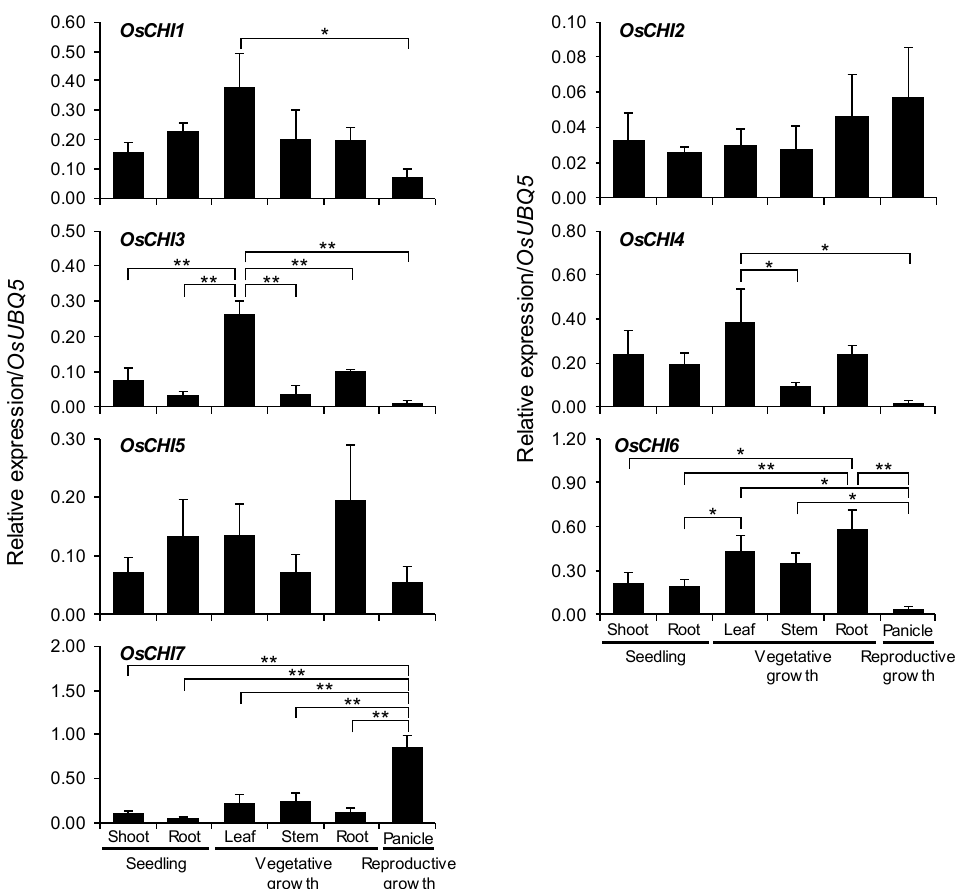
Figure 4. qRT-PCR analysis of OsCHI gene expression in rice seedlings and different tissues. A ubiquitin gene ( OsUBQ5 ) was amplified using specific primers and was used as an internal control. Expression level of each OsCHI gene is presented as the relative expression compared to the OsUBQ5 mRNA level. Asterisks indicate significant differences (* p < 0.05, ** p < 0.005, Tukey’s HSD-test). qRT-PCR analysis was performed on triplicate biological samples.